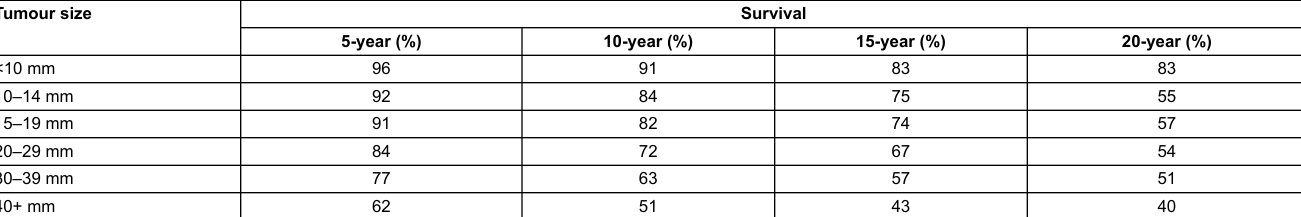
Table 1: Survival from breast cancer by tumour size [15] Tumour